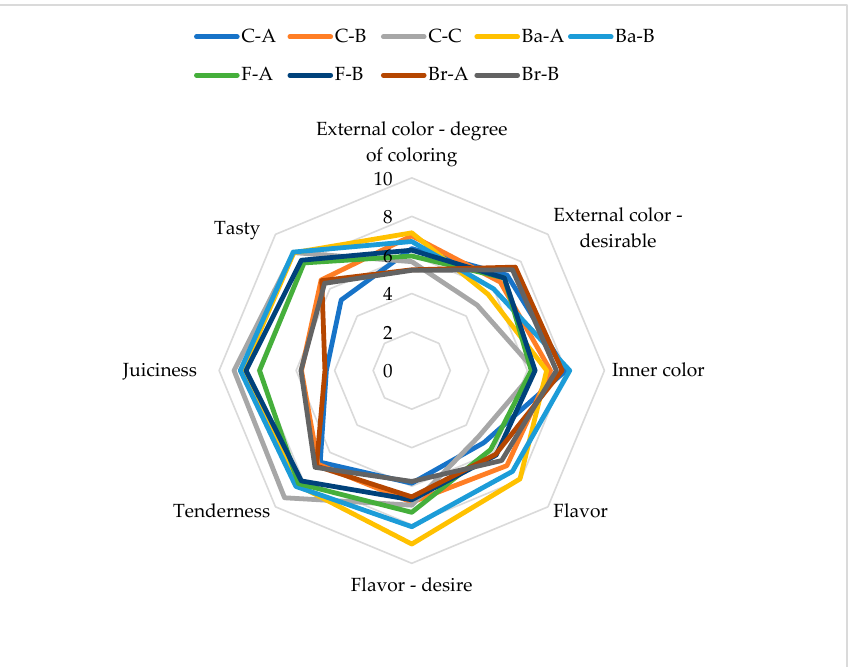
Figure 3. Sensory quality of culinary chicken breast samples. Code designations as in Table 1.